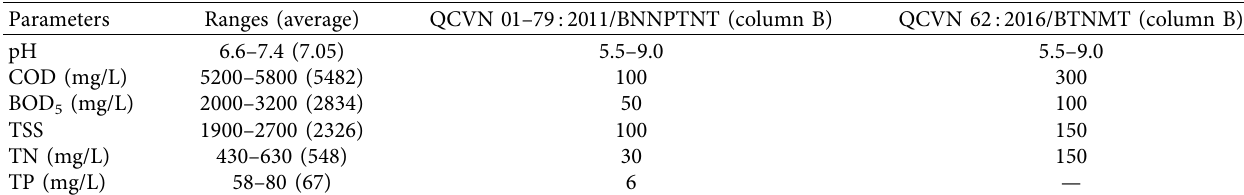
Table 1: The characteristic of influent piggery wastewater of the pilot-scale anaerobic MBBR. Parameters Ranges (average)